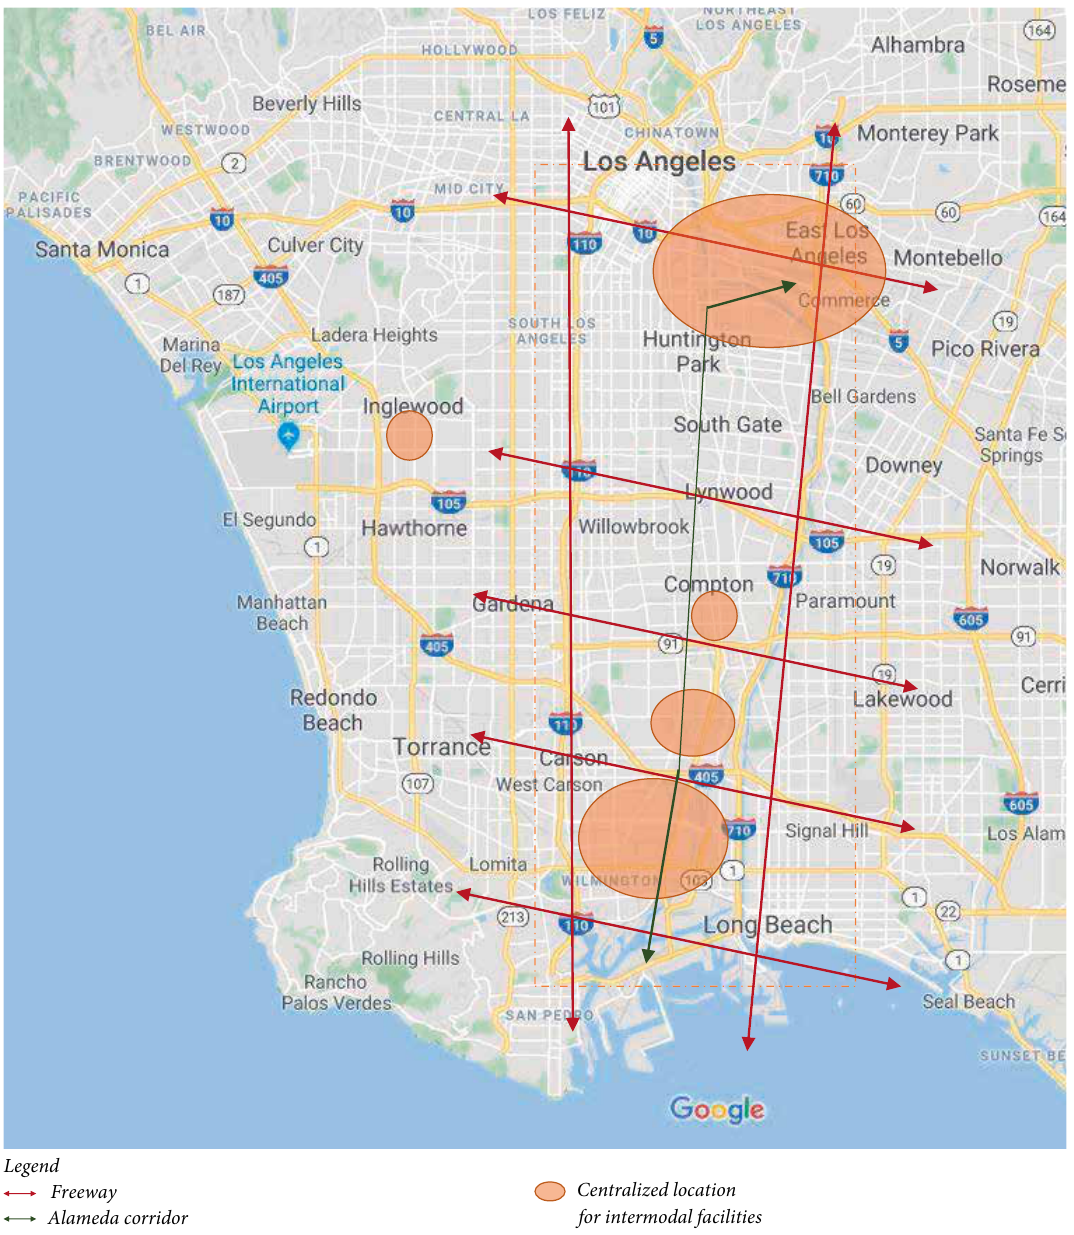
Figure 6: Case study site: ports of Long Beach and Los Angeles in Southern